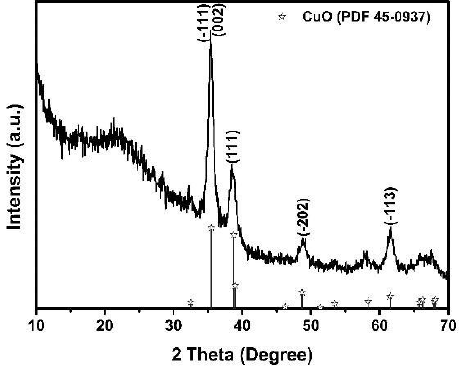
Figure 18. X-ray diffraction patterns of the copper oxide film (CuO) deposited by the automated SILAR prototype using 10 cycles.